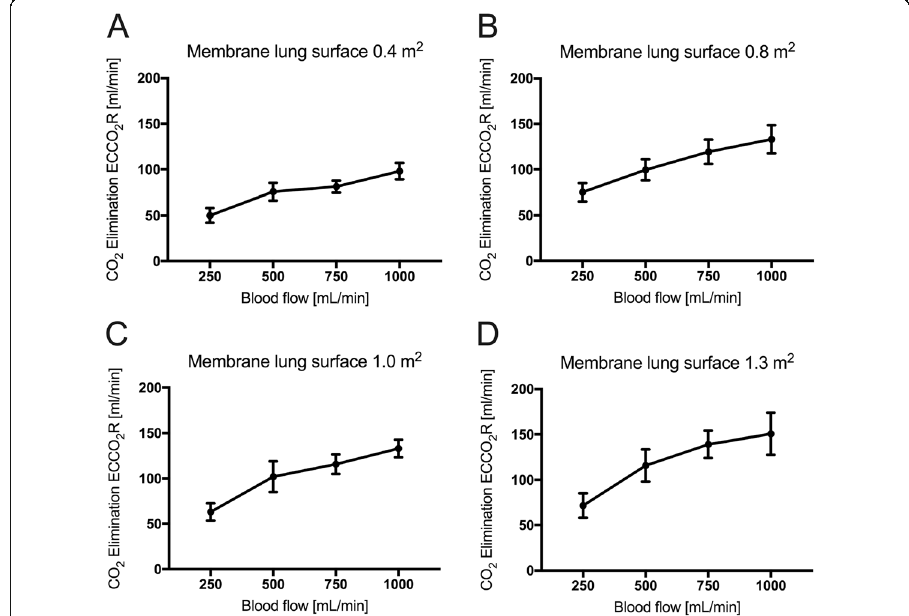
Fig. 1 Extracorporeal elimination of carbon dioxide (CO 2 ) depending on blood flow. Membrane lung surface ranges from 0.4 m 2 ( a ), 0.8 m 2 ( b ), 1.0 m 2 ( c ) to 1.3 m2 ( d ) with a sweep gas flow of 8 L O 2 /min. Blood flow was titrated from 250 to 1000 ml/min. Each data point represents the mean and standard deviation of seven